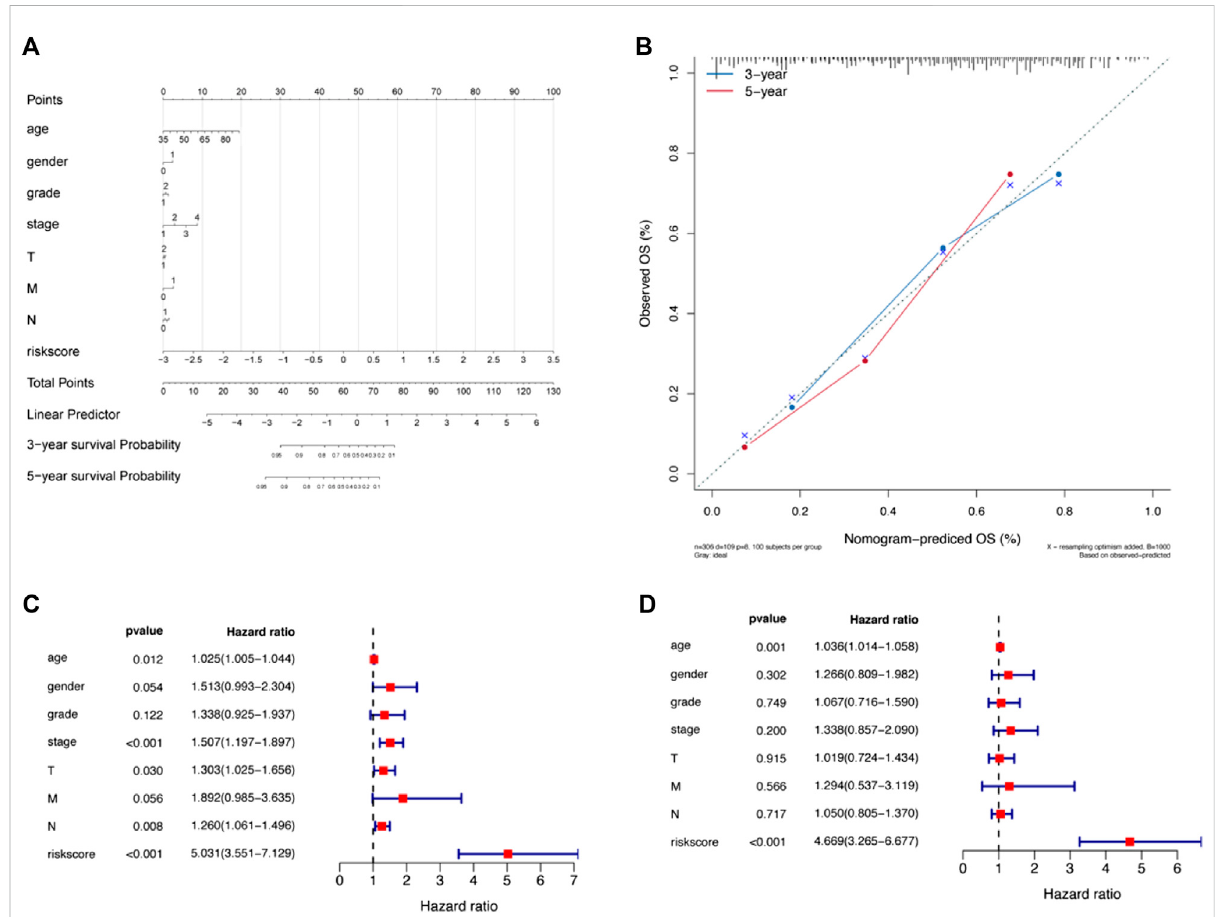
FIGURE 5 A nomogram was constructed combining apoptosis risk scores and clinicopathological characteristics in the cohort from TCGA-STAD. (A) A nomogram predicting 3-and 5-years overallsurvival wasconstructed. (B) Calibration curves ofthenomogram. (C) Results ofunivariateCox analysis of the cohort from TCGA-STAD. (D) Results of multivariate Cox analysis for the cohort from